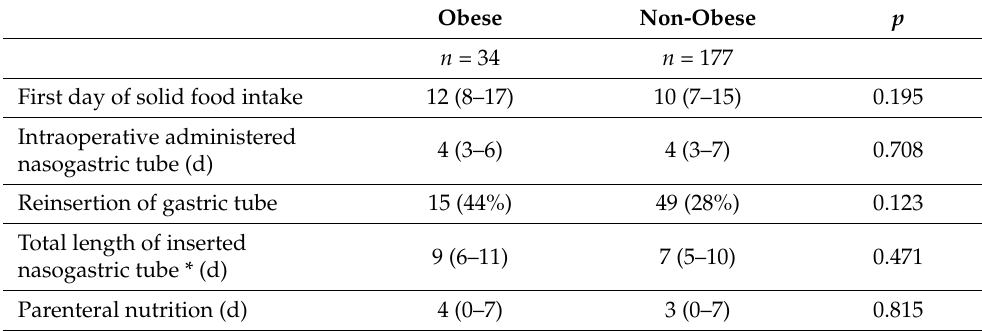
Table 4. Delayed gastric emptying—parameters according to